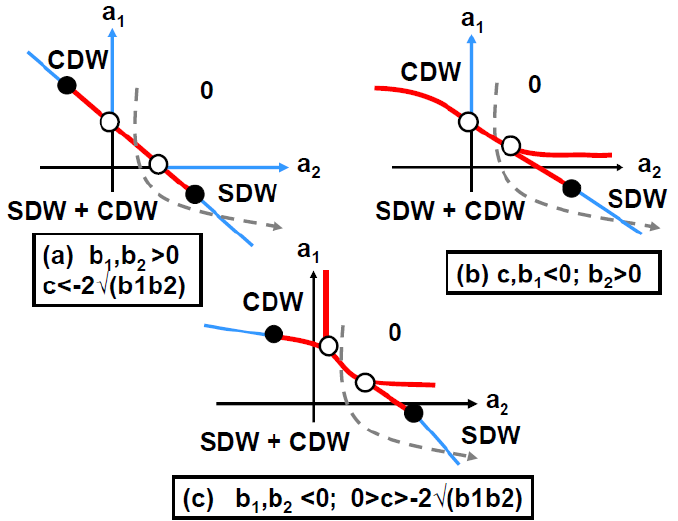
Figure 7. 2k SDW/CDW phase diagrams in function of the Landau coefficients a F for an attractive interaction, c, between the 2k (adapted from Figure 3 in [85]). ( a ) Corresponds to c < −2√(b displayed in Figure A.1); ( b ) Corresponds to c, b > −2√(b b ) and b , b < 0. The notations are defined in Annex A.2. Thin (thick) lines 1 2 1 2 represent 2 nd (1 st ) order transition lines. White dots indicate merging points between transition lines and black dots represent tricritical points. In each phase diagram the grey interrupted lines show a trajectory starting from the uniform phase “0”, crossing, after a 1 st order transition, the SDW + CDW phase to finally reach, after a 2nd order transition, a pure SDW